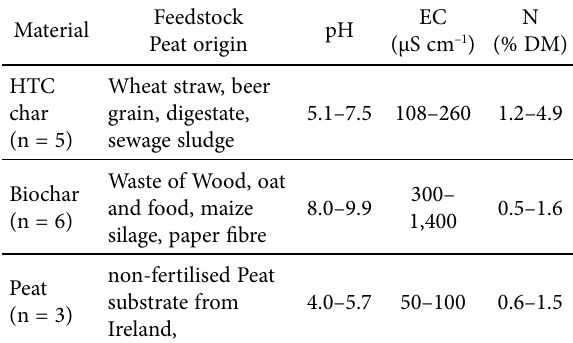
Table 4. Exemplary comparison of ranges of pH, EC and N content of commercial and experimental biochars and HTC chars with peat substrates (Prasad, unpublished), EC – electrical conductivity, N – nitrogen, HTC – hydrothermal